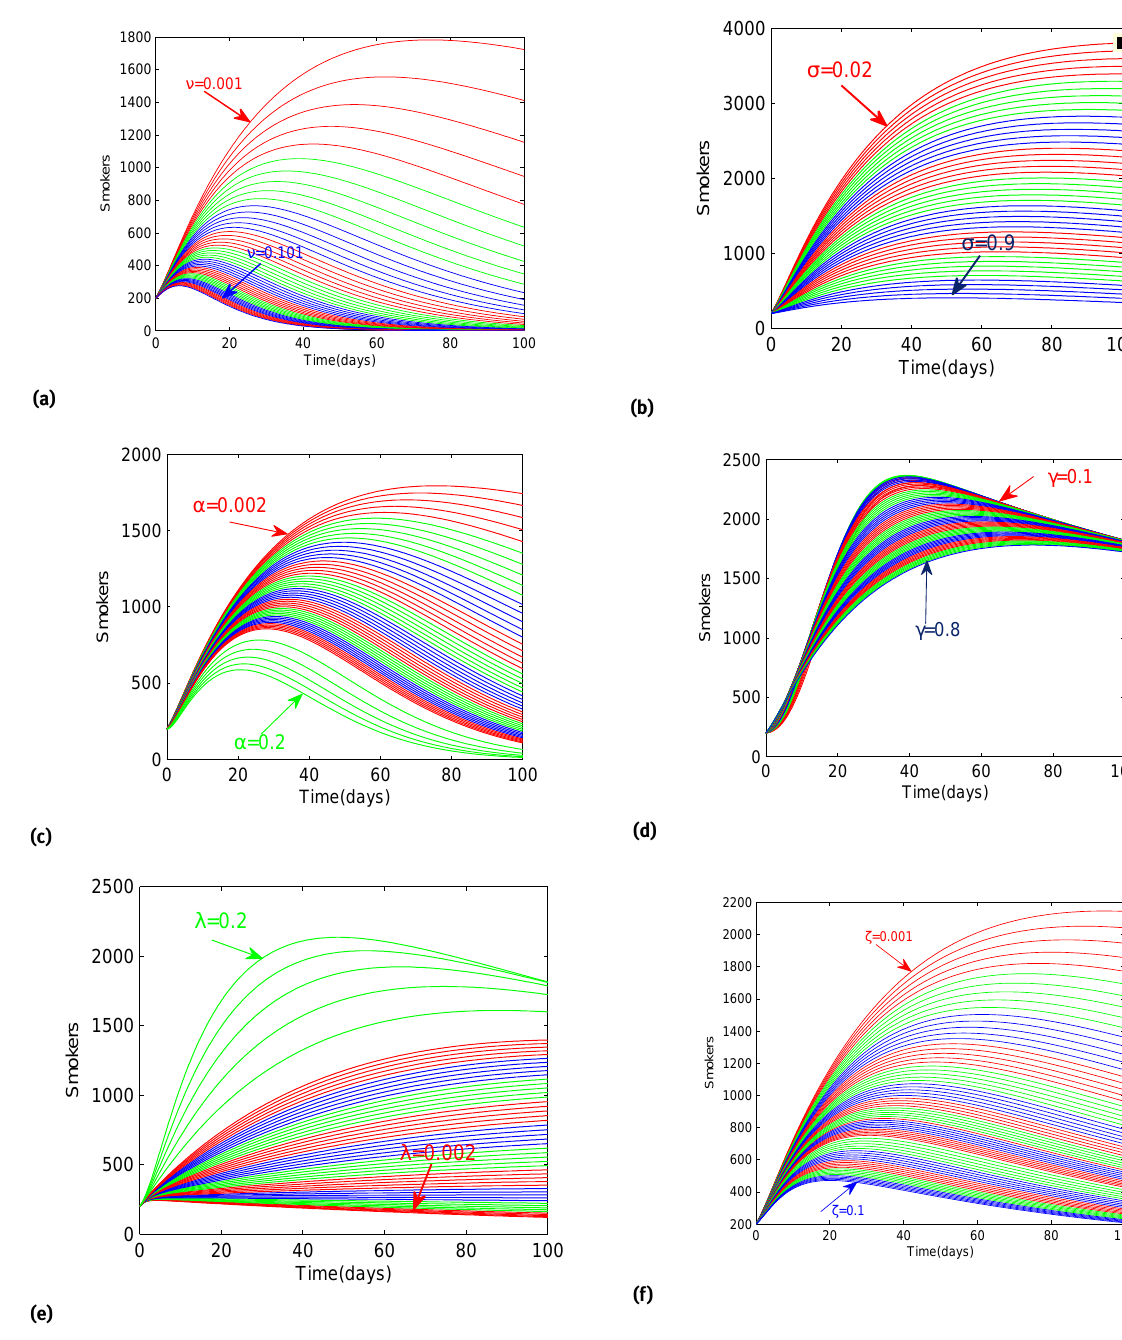
Figure 4: Variation in the endemic level of S * with respect to model